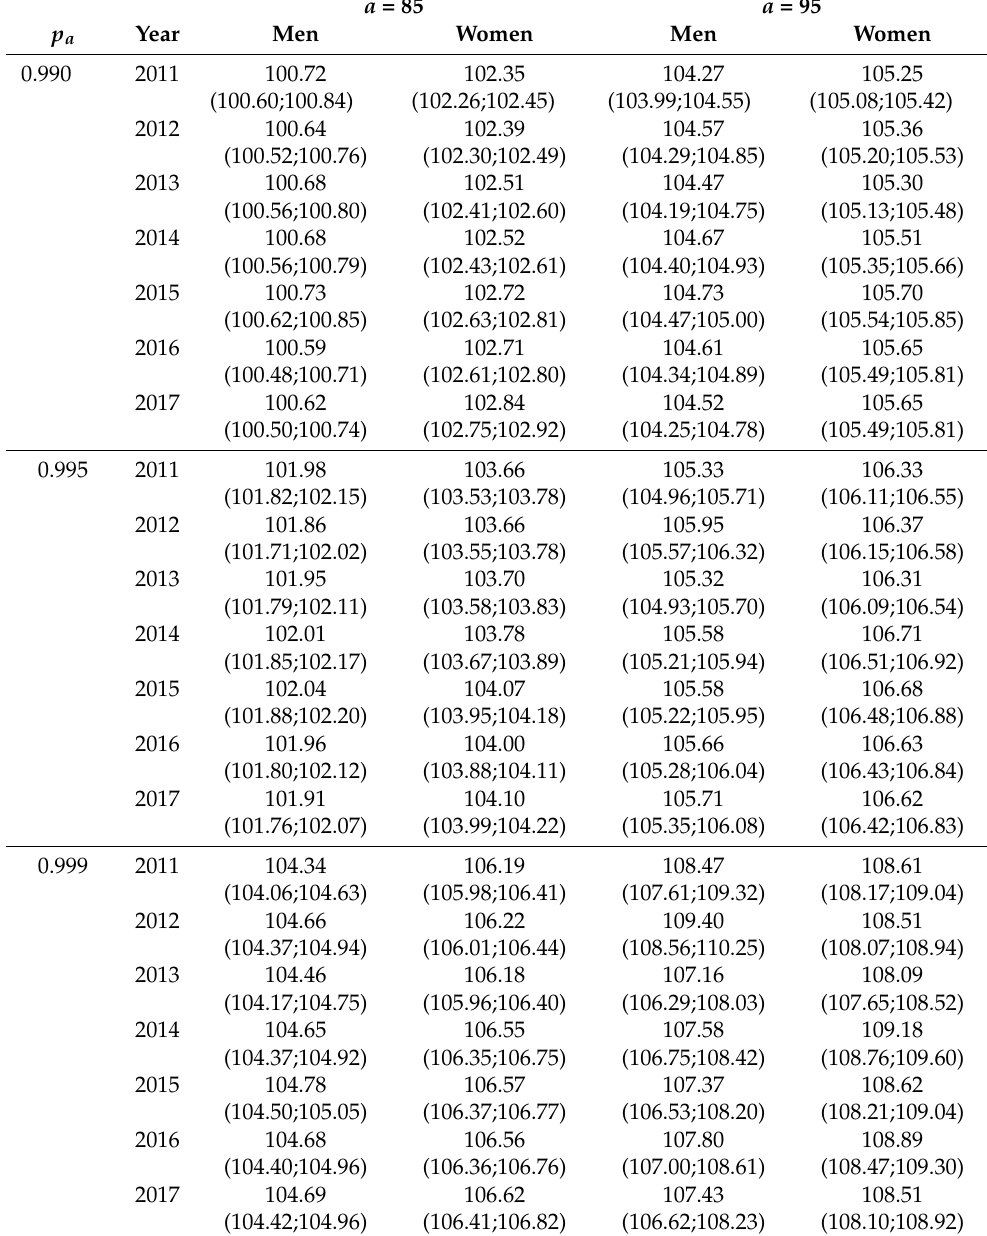
Table 3. Results of estimated CQ p and 90% confidence interval based on Beta Transformed Kernel a Estimator (BTKE) for the age-at-death of the population aged over 65 in Spain separately for men and women and conditional ages of the deceased population ( a = 85,95), from 2011 to